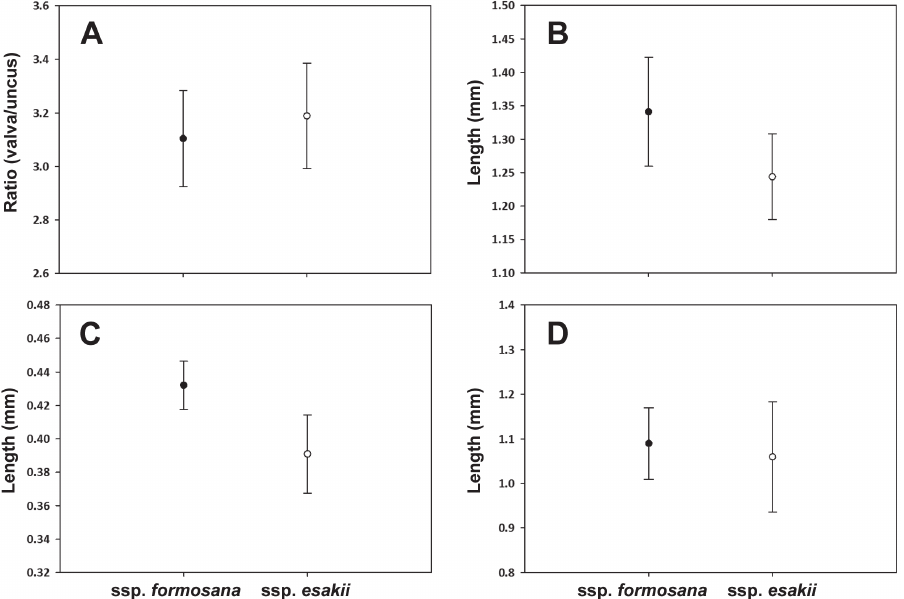
Figure 2. Morphological comparison of genitalia between ssp. formosana and ssp. esakii . A Shape of geni- talia (t-test, t = -0.9868, d.f. = 18, p = 0.3368) B Valva (t-test, t = 2.9904, d.f. = 18, p < 0.05) C Uncus (t-test, t = 4.6152, d.f. = 18, p<0.001) D Phallus (t-test, t = 0.6356, d.f. = 18, p =